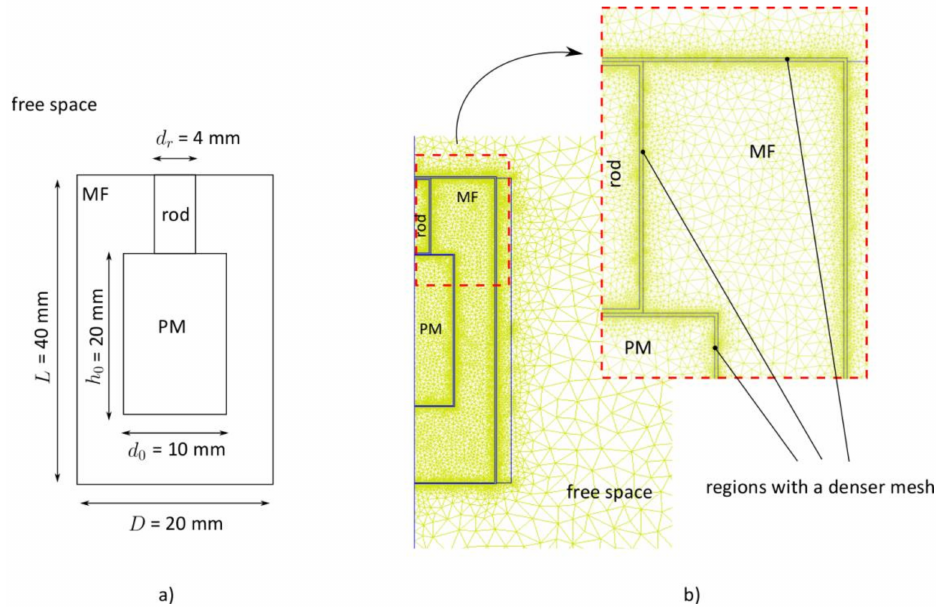
Figure 9. ( a ) Dimensions of the model; ( b ) FEMM 2D axisymmetric model in preprocessor mode, where mesh details are shown. Denser mesh is prescribed to the integration paths used with the SIM.